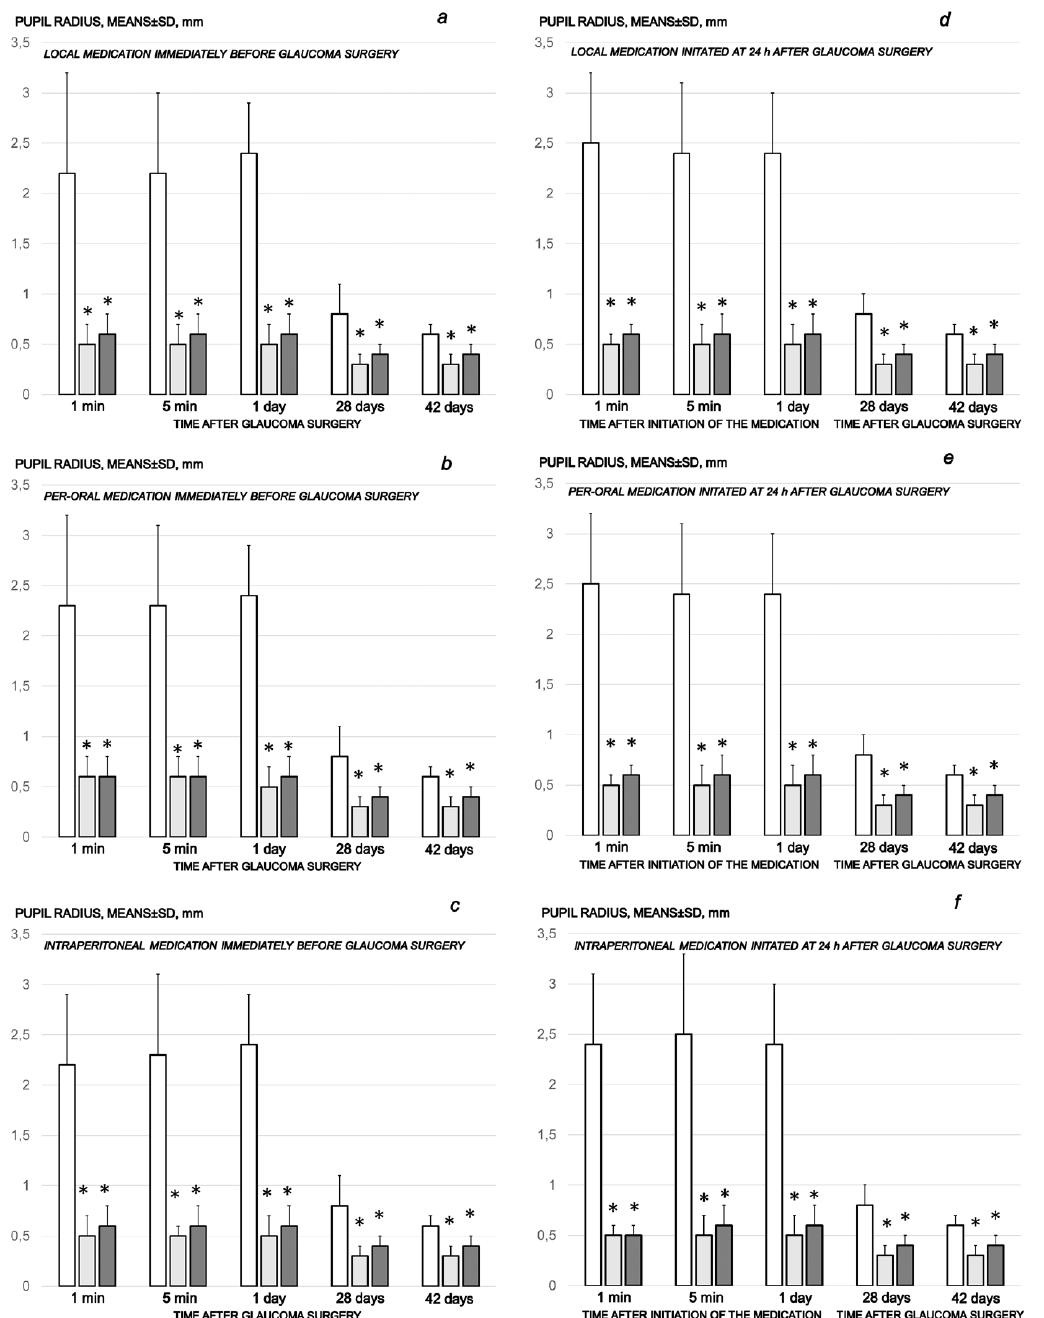
Figure 2. Cauterization of the three episcleral veins induced mydriasis, enormous at the earlier post-injury periods, and present until the end of the experiment at the end of the sixth post-injury week. Counteracting effect of BPC 157 medication daily regimen, prophylactic ( a – c ) or curative ( d – f ) (gray bars, light gray bars µ g-regimen, dark gray bars ng-regimen (0.4 µ g/eye, 0.4 ng/eye; 10 µ g/kg, 10 ng/kg) given locally as eye drops in each eye ( a , d ), intraperitoneally (last application at 24 h before sacrifice) ( b , e ) or per-orally in drinking water (0.16 µ g/mL, 0.16 ng/mL, 12 mL/rat until the sacrifice, first application given intragastrically) ( c , f )), started prophylactically (immediately before glaucoma surgery) or as curative treatment (at 24 h after glaucoma surgery). Controls (white bars) simultaneously received an equal volume of distilled water (two drops/eye), saline intraperitoneal application (5 mL/kg) or per-oral drinking water (12 mL/day/rat). A total of 6 rats/group/interval. * p < 0.05, at least, vs.